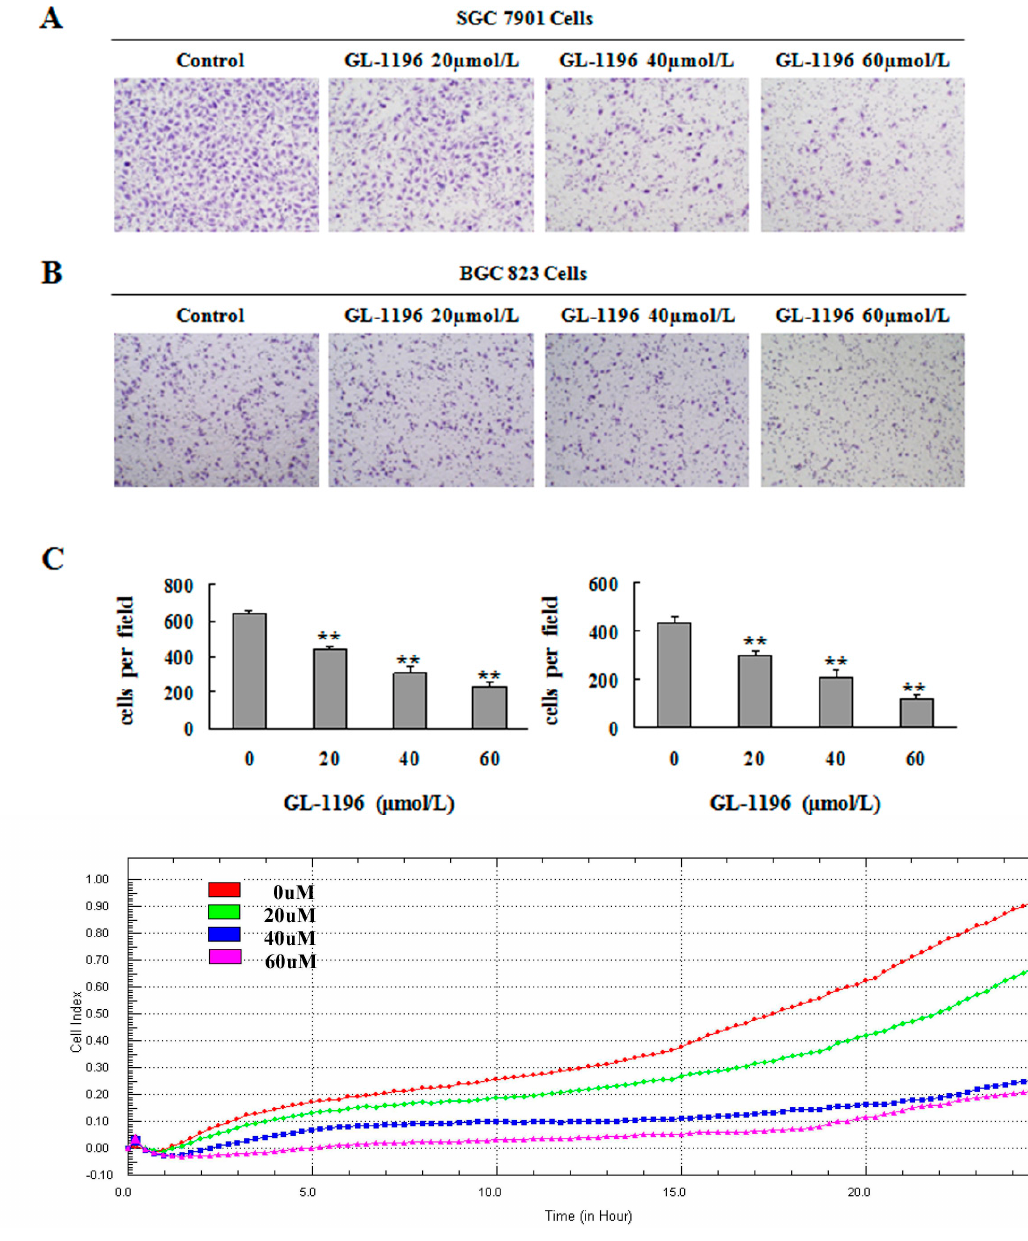
Figure 3. GL-1196 suppresses the invasive capacity of human gastric cancer cells. The invasive capability of SGC7901 ( A ) and BGC823 ( B ) cells was evaluated by chemotaxis chamber matrigel invasion assay. The magnification is 100×, and the number of invading cells is shown as bar diagram ± SEM; ( C ) the left one is for SGC7901 cells; the right one is for BGC823 cells, ** p < 0.01; ( D ) the effect of GL-1196 on MKN-45 cells invasive ability was detected by real time invasion monitoring.